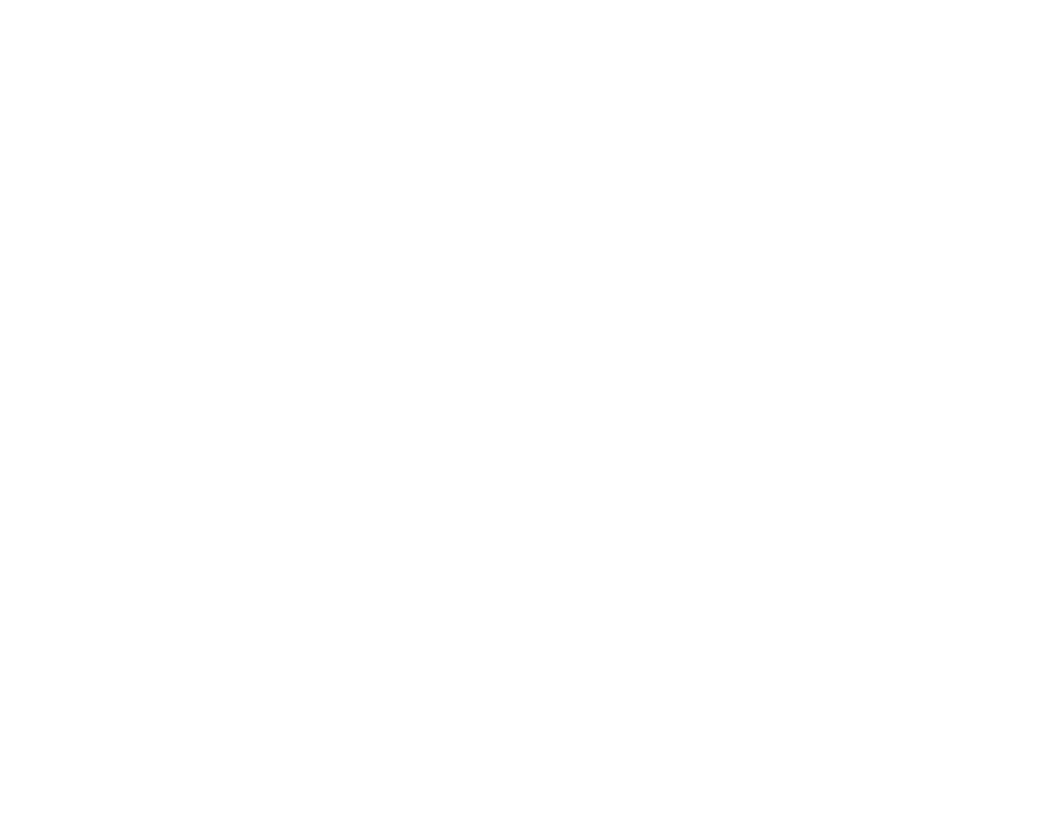
FIGuRe A1 | Distribution of expressed regions proximal to RCS2/CentO in Cen4 and Cen8 . The distributions of reads mapped on Cen4 (A) and Cen8 (B) were graphed in GBrowse, as in Figure 2 . Os04g0234600 in Cen4 is extremely highly expressed (black triangle). Os08g0319450 in Cen8 is located in the small RCS2/